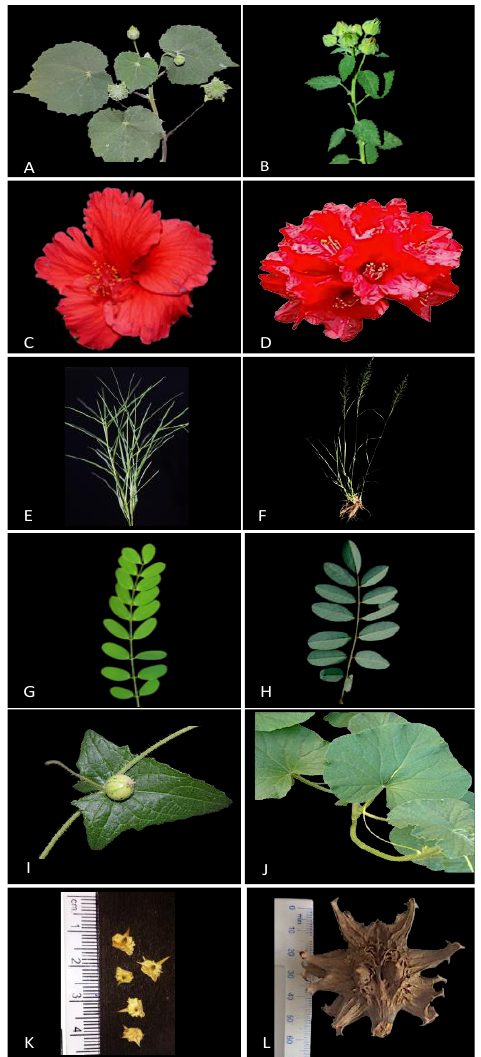
Figure 3. Morphological resemblance between the expected authentic species and non-authentic species identified by DNA barcoding. Abutilon indicum versus Sida cordifolia ( A , B ); Cynadon dactylon versus Sporobolus helvolus ( C , D ); Hibiscus rosa-sinensis versus Rhododenron delavayi ( E , F ); Senna auriculata versus Indigofera tinctoria ( G , H ); Mukia maderaspatana versus Cucumis melo ( I , J ); and Tribulus terrestris versus Harpaophytum procumbens ( K , L ).